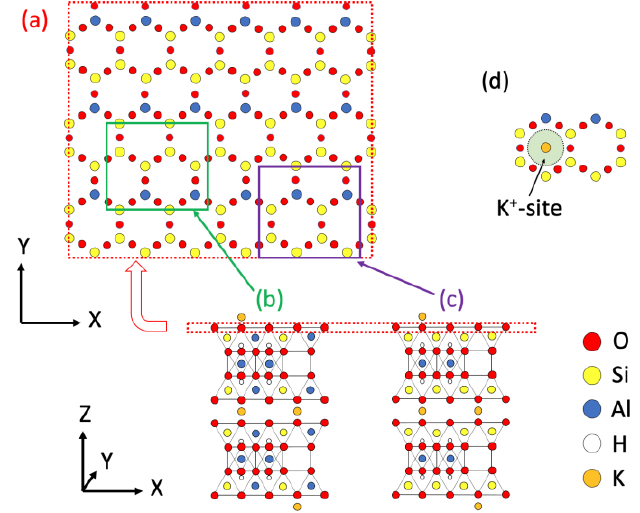
Figure 2. Schematic image of muscovite structure ( a ) XY view ( b , c ) XZ views of the surface ( d ) K + -site (yellow: Si, blue: Al, red: O, white: H, orange: K). The unit cell size of muscovite is (ΔX, ΔY, ΔZ) = (0.5199 nm, 0.903 nm, 2.011 nm), and